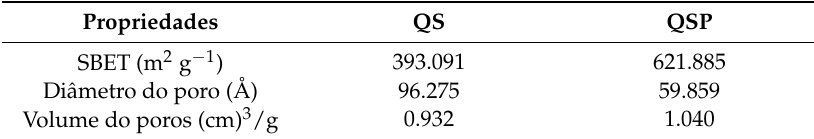
Table 2. Properties from Brunauer–Emmett–Teller (BET) analysis of CS and CSP materials.